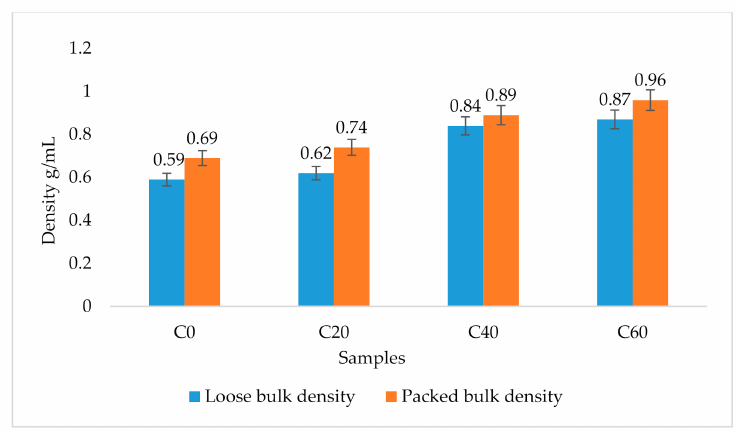
Figure 3. Bulk density of cookie flours. Error bar values are actual values obtained. C0: control (100% wheat cookies); C20: 15% sorghum and 5% termite substitution level; C40: 30% sorghum and 10% termite substitution level; C60: 45% sorghum and 15% termite substitution